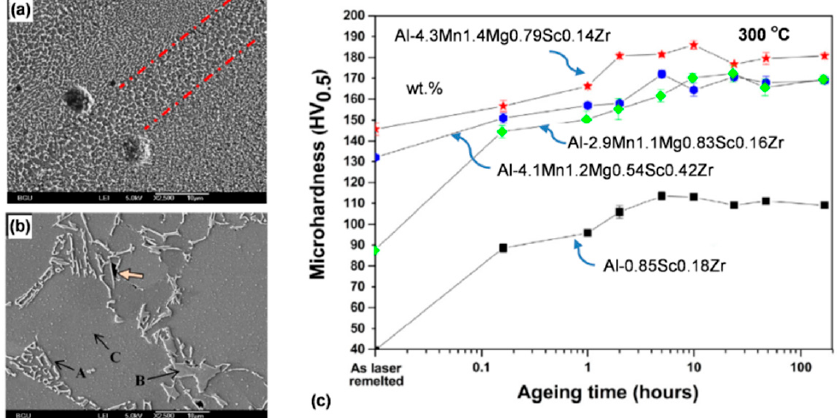
Figure 31. Refinement of microstructure of AlSi10Mg alloy after selective laser melting ( a ) as compared to the conventionally cast state ( b ), A—Al − Si eutectic, B—Si dispersion, C—Fe-containing intermetallics [143]; ( c ) aging responses of laser remelted Al − Mn − Sc and Al − Sc − Zr alloys at 300 °C [142].